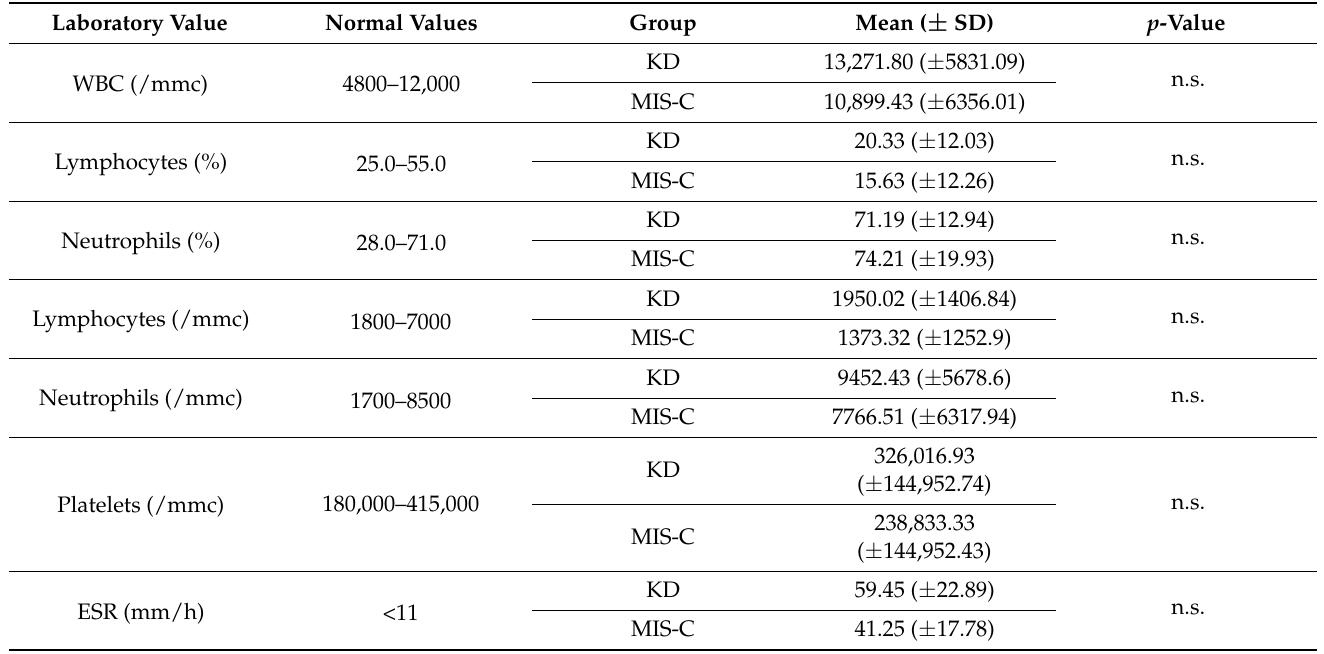
Table 2. Laboratory values of MIS-C and KD patients during the acute stage. SD stands for standard